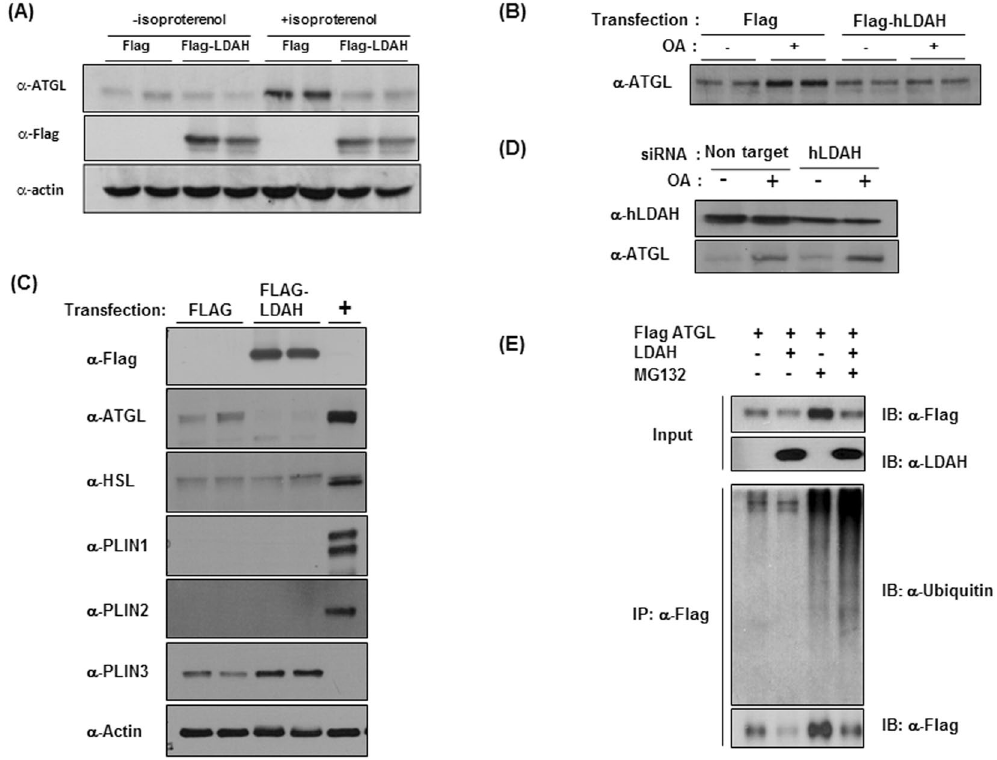
Figure 6. LDAH decreases the levels of ATGL. ( A ) ATGL levels in Flag or Flag-LDAH transfected HEK293 during TAG hydrolysis as described in Fig. 5B. ( B ) Flag or Flag-human LDAH (hLDAH) were transfected to HEK293 cells, and cells were cultured with or without OA (360 μ M) for 24 h. ATGL was detected using α nti- ATGL antibody. ( C ) Flag or Flag-LDAH were transfected to HEK293 cells. Cells were stimulated with OA for 24 h, and HSL, PLIN1, PLIN2, PLIN3 and ATGL were detected by immunoblotting with specific antibodies. Anti-actin antibody was used for loading control. Differentiated 3T3L1 adipocytes ( + ) were used for expression control. ( D ) Non-target or hLDAH siRNA were transfected to HEK293 cells. After 48 h OA (360 μ M) was added to the culture media for 24 h. The expression levels of hLDAH and ATGL were determined by immunoblotting. ( E ) Flag-ATGL and/or LDAH were transfected to HEK293 cells as indicated. 24 h after transfection cells were treated with OA (360 μ M for 24 h) followed by MG132 for 8 h as indicated in the figure. Flag-ATGL was pulled- down with an anti-Flag M2, and immunoblots were performed with anti-ubiquitin, anti-Flag, and anti-LDAH